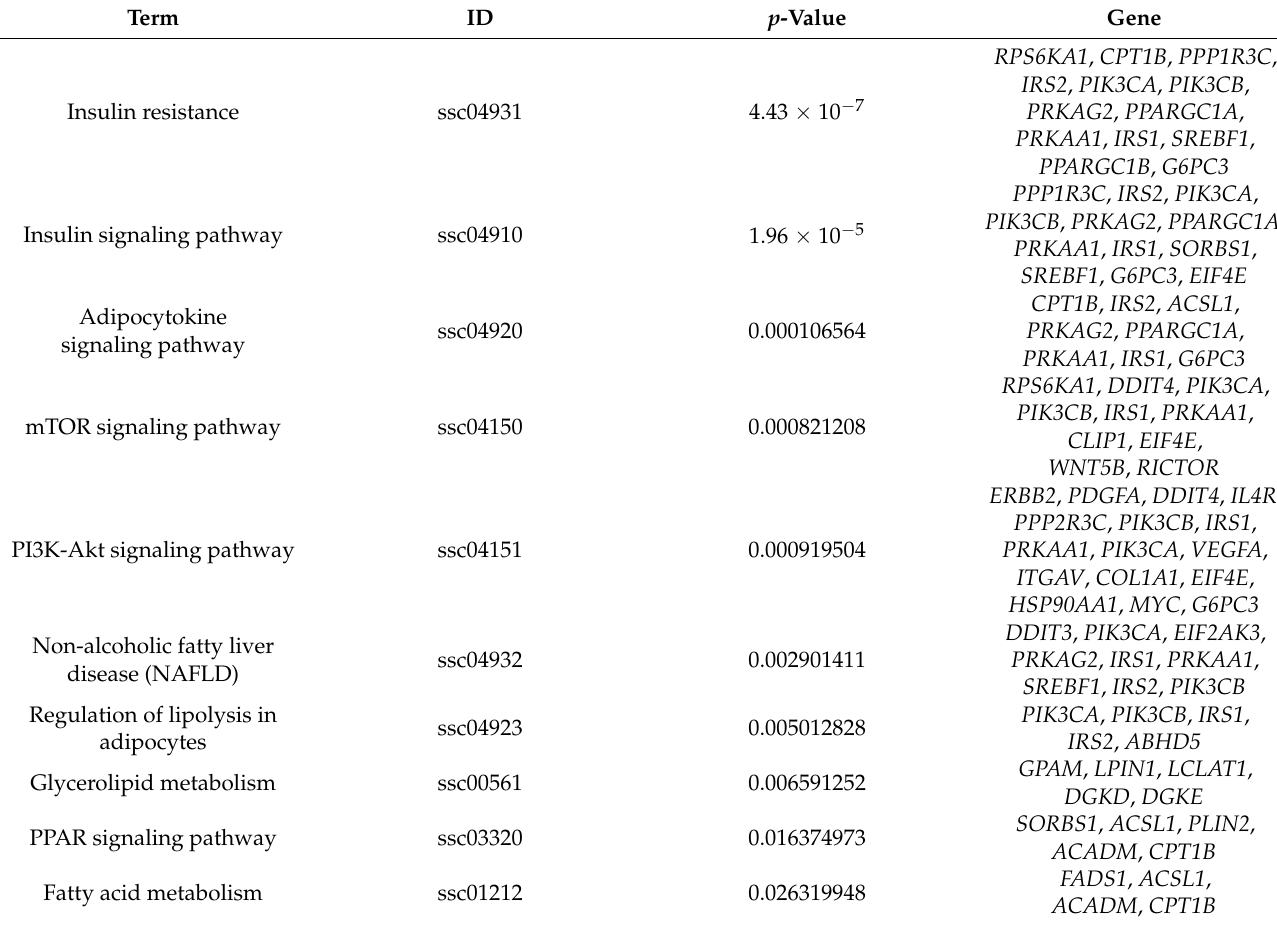
Table 2. KEGG pathway enrichment analysis of potential differentially expressed target genes